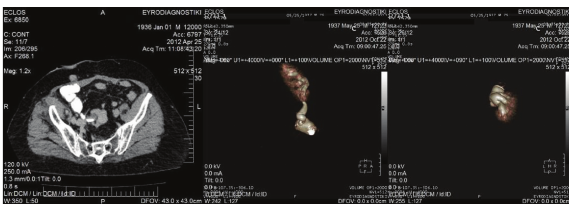
Figure 3: Postoperative and CT-pyelography (3D) of case